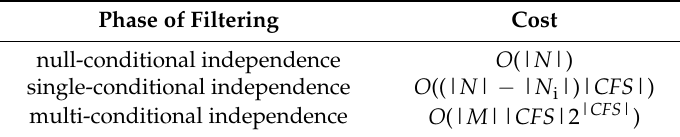
Table 2. The time complexity in the phase of three-layer